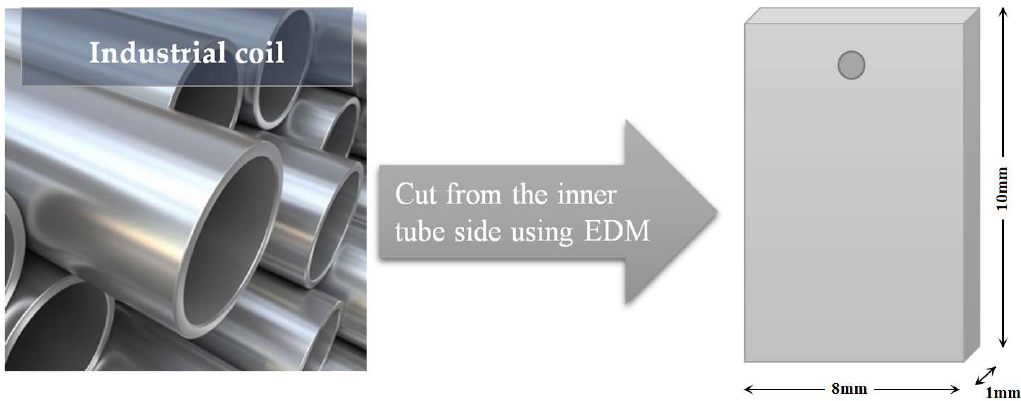
Figure 4. Illustration of JSR coupons sampling.